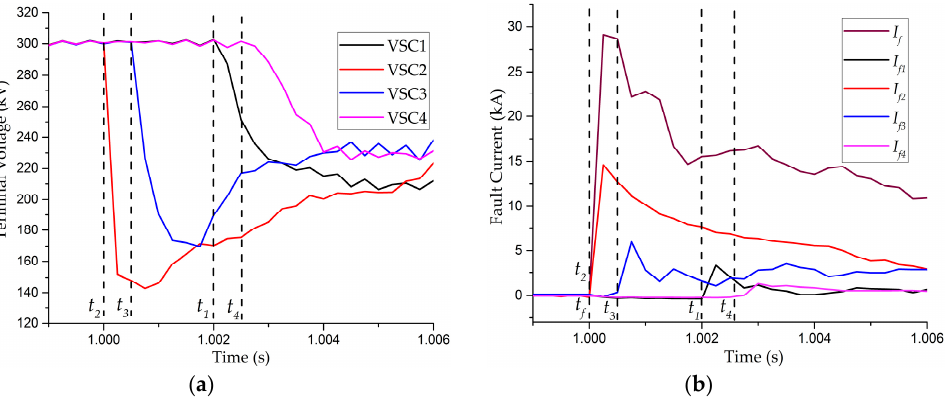
Figure 9. Propagation time delay in MTDC network in case of fault near VSC2. ( a ) Voltage response, ( b ) current response.